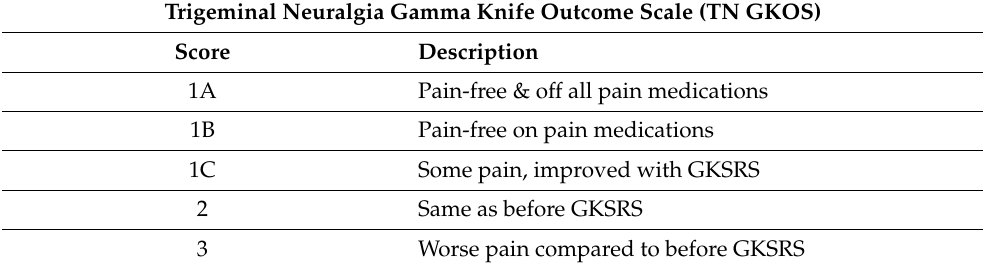
Table 1. Trigeminal Neuralgia Gamma Knife Outcome Scale.